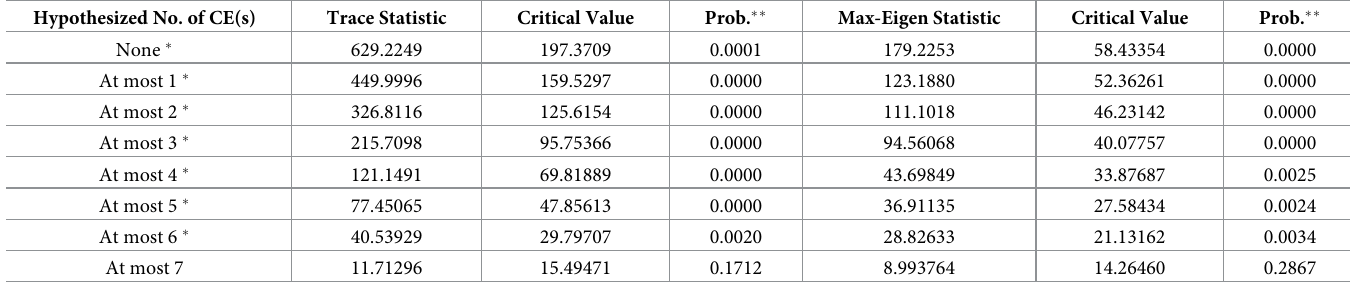
Table 3. Results of multivariate Johansen and Juselius (JJ) cointegration test. Hypothesized No. of